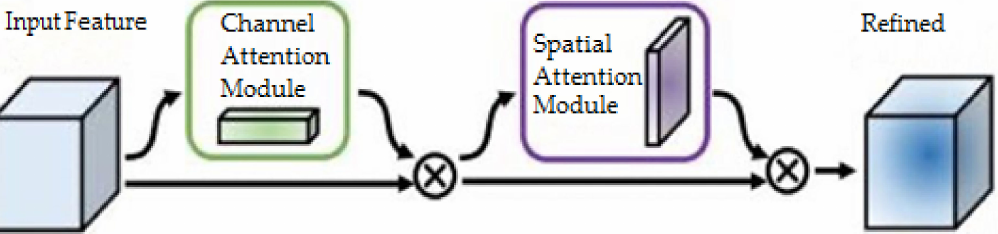
Figure 6. Structure of